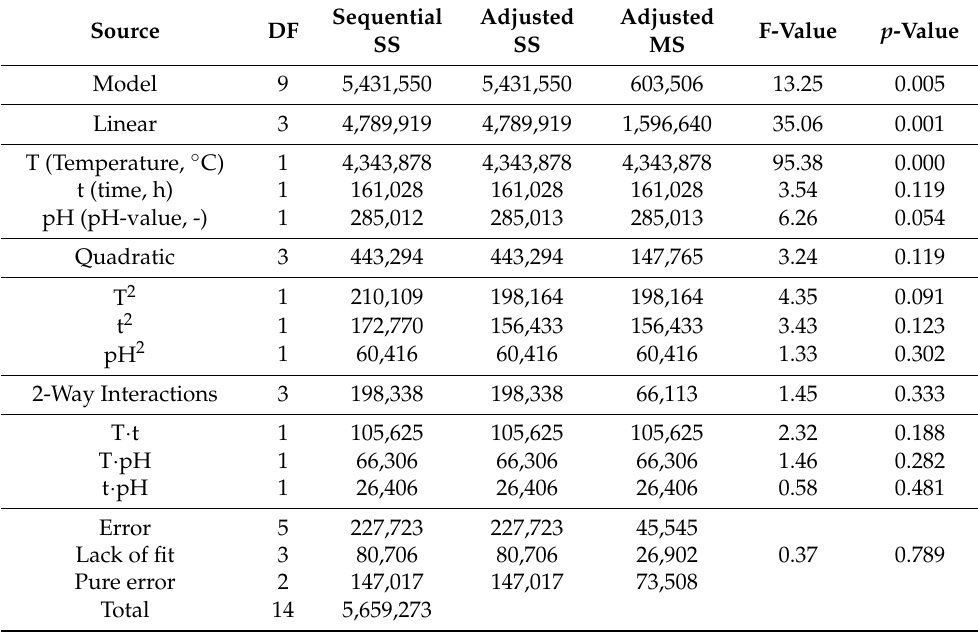
Table A2. ANOVA for the model of DOC. DF: degrees of freedom, SS: sum of squares, MS: mean squares.